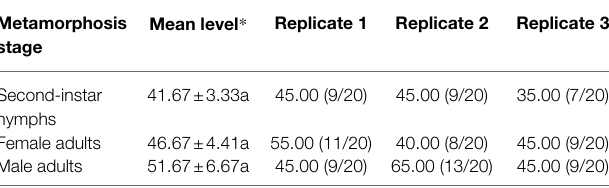
TABLE 3 | Transmission efficiency (mean percentage ± SE) of tomato zonate spot virus (TZSV) by Frankliniella occidentalis at different developmental stages.